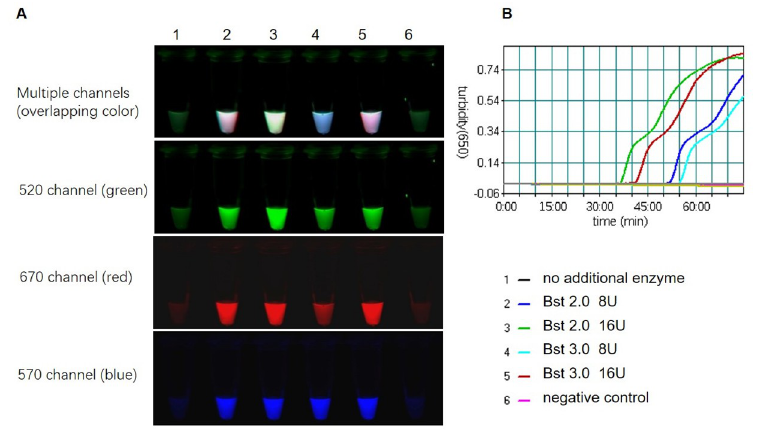
Fig 5. The effect of different strand-displacing enzymes on the mLAMP reaction. The fluorescent mLAMP products were imaged separately using multiple channels (A), and the turbidity was monitored by a real-time turbidimeter (B). Amplification time dependence upon different strand-displacing enzymes with different working amounts. Bst 2.0 WarmStart showed shorter amplification times than Bst 3.0 in the mLAMP reaction. 1: Without addition of enzyme, the reaction was completely inhibited without any amplification; 2: each reaction with 8 U Bst 2.0 WarmStart had an initial amplification time of 52 minutes, 3: each reaction with 16U Bst 2.0 WarmStart had an initial amplification time of approximately 36 minutes, 4: each reaction with 3U Bst 3.0 had an initial amplification time of 55 minutes, 5: each reaction with 16U Bst 3.0 had an initial amplification time of 42 minutes, 6: negative control.